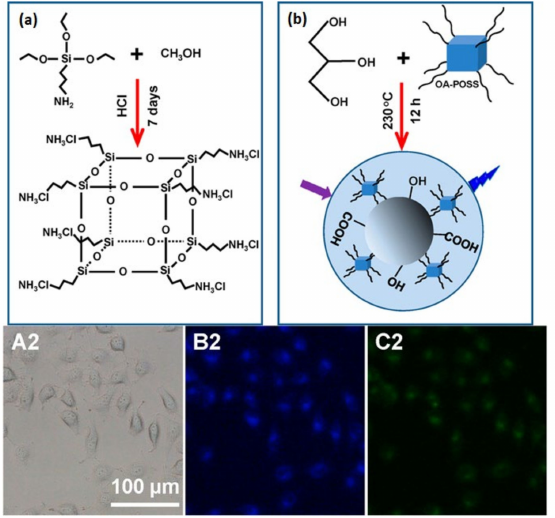
Figure 10. ( a ) Illustration for the hydrolytic condensation of APTES to produce OA-POSS and ( b ) preparation of carbon dots (CDs/POSS) with glycerol as carbon source and OA-POSS as passivation agent. Fluorescent microscope images of ( A2 – C2 ) MCF-7 cells labeled with CDs/POSS. ( A2 ) Bright- field images; ( B2 ) with an excitation wavelength of 340 nm; ( C2 ) with an excitation wavelength at 495 nm. Reprinted with permission from ref. [42]. Copyright 2015 American Chemical